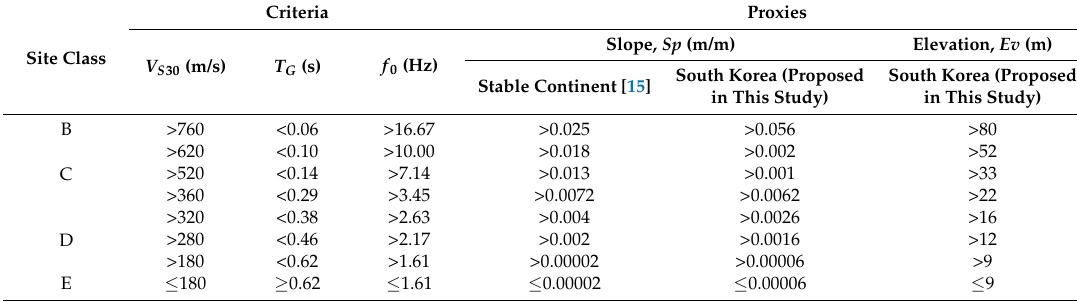
Table 5. Geo-proxy-based empirical site classification proposal according to the slope and elevation for domestic application.